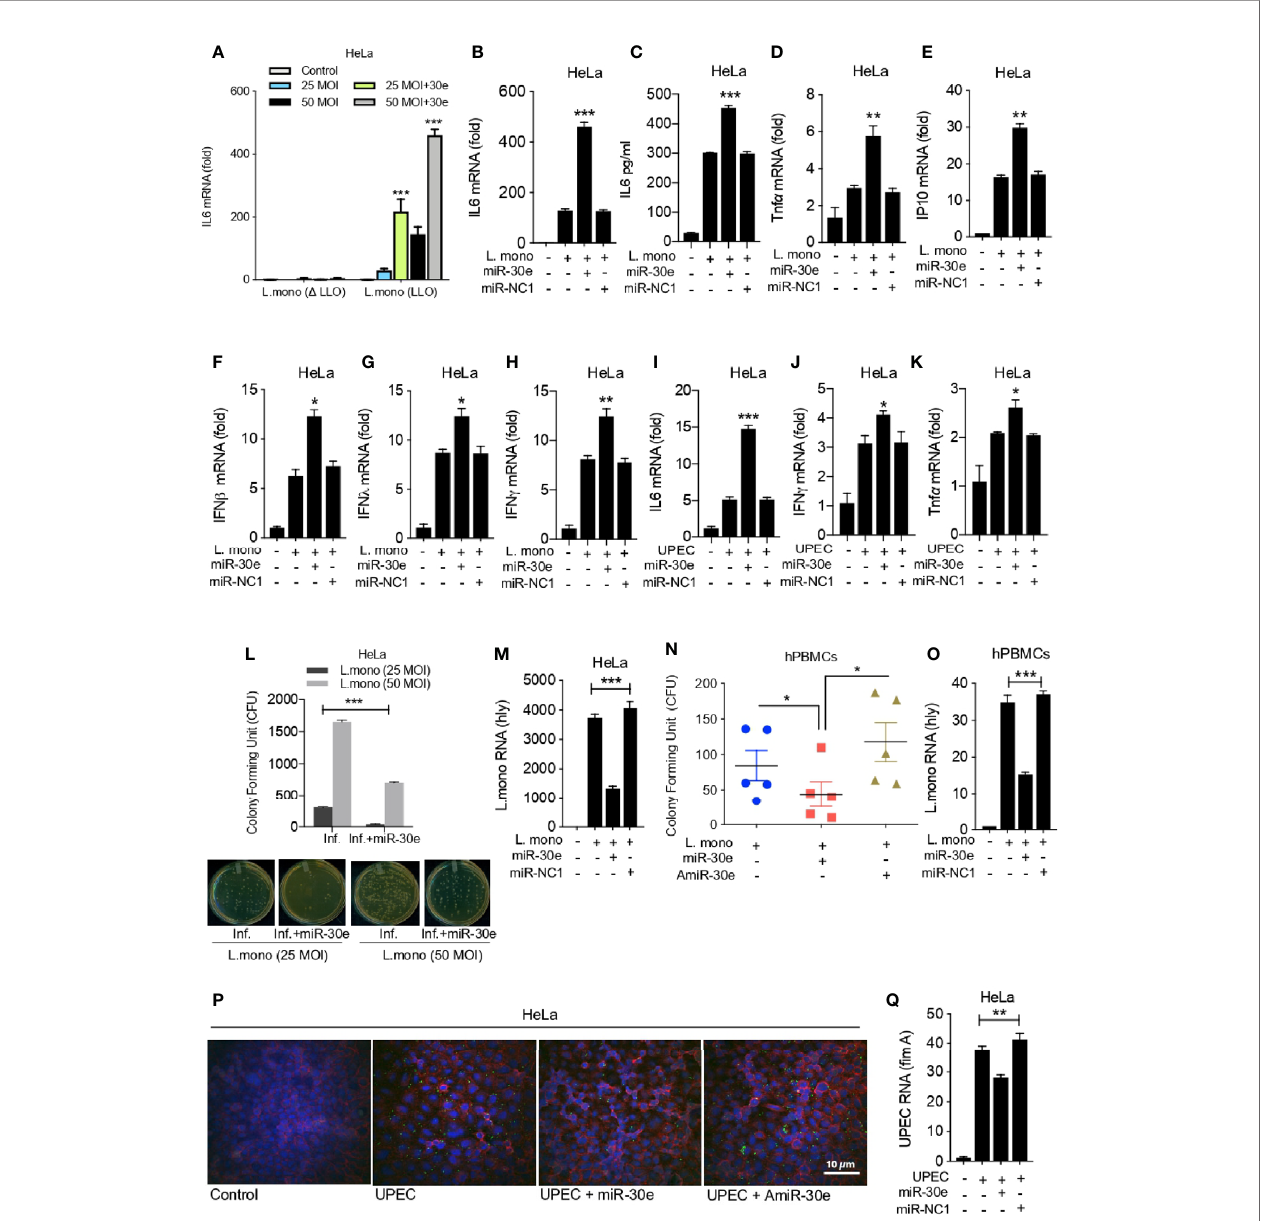
FIGURE 3 | miR-30e-5p elevates innate immunity by inhibiting bacterial replication. Quanti fi cation of the fold changes in the relative abundances of respective innate immune transcripts and bacterial transcripts after the 24 h of L. mono. infection in the cells transfected with miR-30e (50 nM) or miR-NC1 (50 nM) prior to infection. Expression of IL6 (A) in HeLa cells in presence of listeriolysin O (LLO)-de fi cient and LLO-suf fi cient strain of L. mono . In HeLa cells at (B) mRNA level and (C) protein level. Quanti fi cation of (D) TNF a , (E) IP10 , (F) IFN b , (G) IFN l , (H) IFNy . Quanti fi cation of (I) IL6 , (J) TNF a , (K) IFNy after the 24 h of UPEC infection in the HeLa cells transfected with miR-30e (50 nM) or miR-NC1 (50 nM) prior to infection. Estimation of L. mono. infection in presence of miR-30e by colony forming assay (CFU) in (L) HeLa cells and bacterial transcript ( hly ) quanti fi cation in (M) HeLa cells. (N) CFU in hPBMCs. (O) Bacterial transcript ( hly ) quanti fi cation. Estimation of UPEC infection in presence of miR-30e by (P) microscopy and (Q) bacterial transcript ( fi mA ) quanti fi cation. Data are mean +/- SEM of triplicate samples from single experiment and are representative of two independent experiments. *** P < 0.001, ** P < 0.01 and * P < 0.05 by one-way ANOVA Tukey